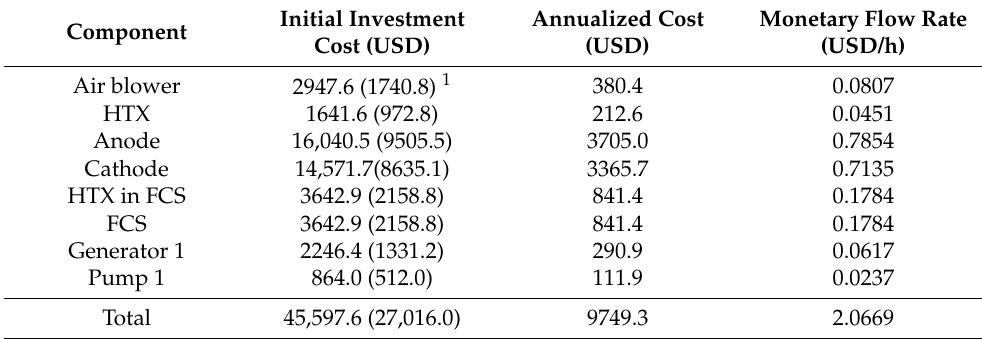
Table 3. Initial investments, annualized costs and corresponding monetary flow rates of each